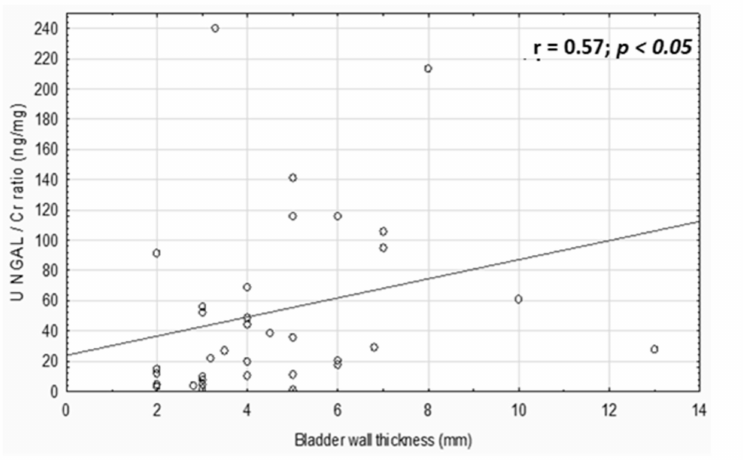
Figure 1. Correlation between uNGAL/Cr ratio and bladder wall